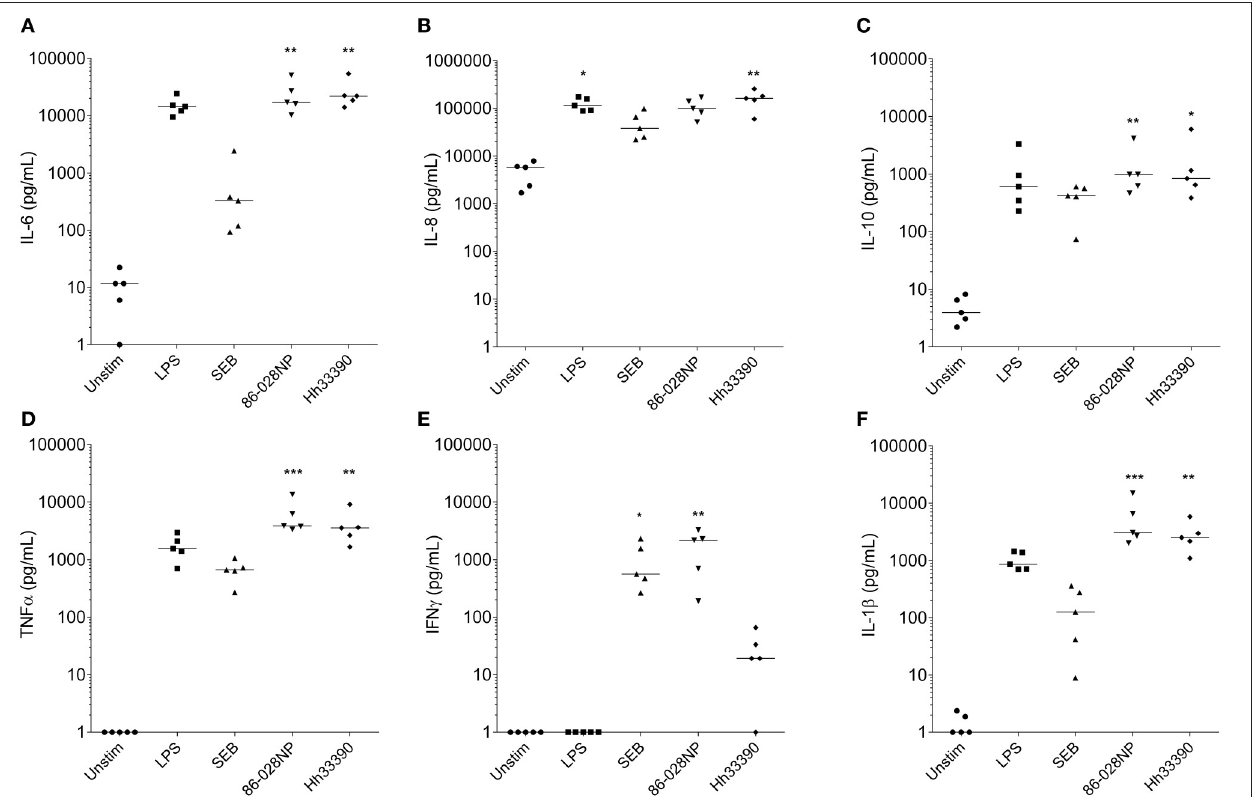
FIGURE 3 | Inflammatory mediator release (pg/mL) from PBMCs at 24h post-treatment with NTHi or H. haemolyticus . Concentration of inflammatory mediators IL-6 (A) , IL-8 (B) , IL-10 (C) , TNF α (D) , INF γ (E) , and IL-1 β (F) following treatment of adult PBMCs with either media alone (unstim), lipopolysaccharide (LPS), Staphylococcal enterotoxin B (SEB), NTHi86-028NP, or H. haemolyticus 33390. The horizontal bars depict the median analyte level for each treatment group ( n = 5 ). * p < 0.05 , ** p < 0.01 ; *** p < 0.001 when compared with unstimulated cells using a Kruskal-Wallis and Dunn’s